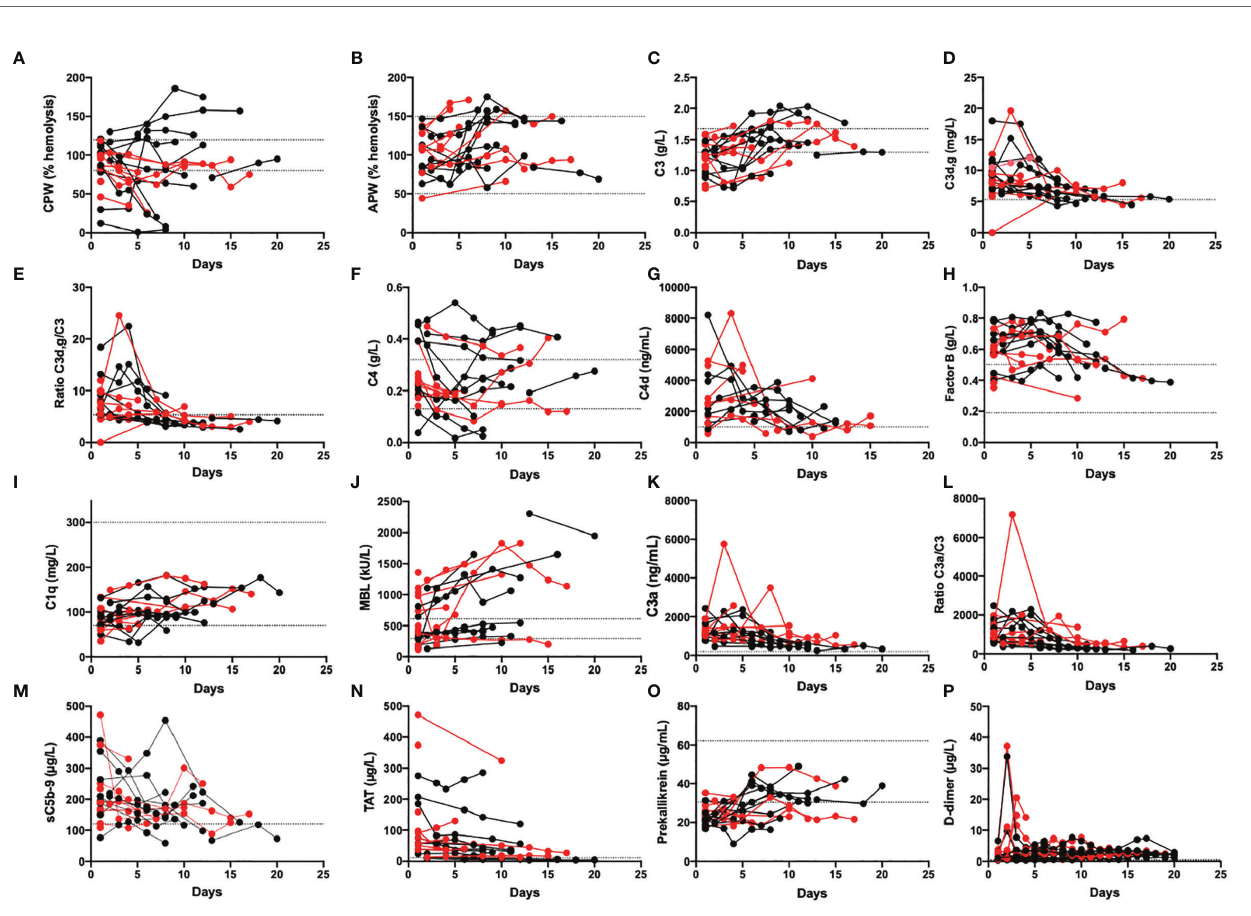
FIGURE 3 | Longitudinal monitoring of thromboin fl ammation activation in critically ill COVID-19 patients. Analyzed complement related parameters included activation by the CPW and APW (A, B) . levels of C3, C3d,g and the C3d,g/C3 ratio (C, D, E) , C4 and C4d (F, G) , Factor B, C1q, and MBL (H, I, J) , the activation markers C3a, the C3a/C3 ratio, and the sC5b-9 complex (K, L, M) . Additional parameters included the levels of TAT (N) , prekallikrein (O) , and D-dimer (P) . Red dots: patients who died; black dots: patients who survived. The dotted lines mark the reference range. The presented data are from 19 of the fi rst included patients that were followed for up to 1 month. CPW, classical pathway of complement; APW, alternative pathway of complement; MBL, mannose binding lectin; TAT, thrombin-antithrombin.